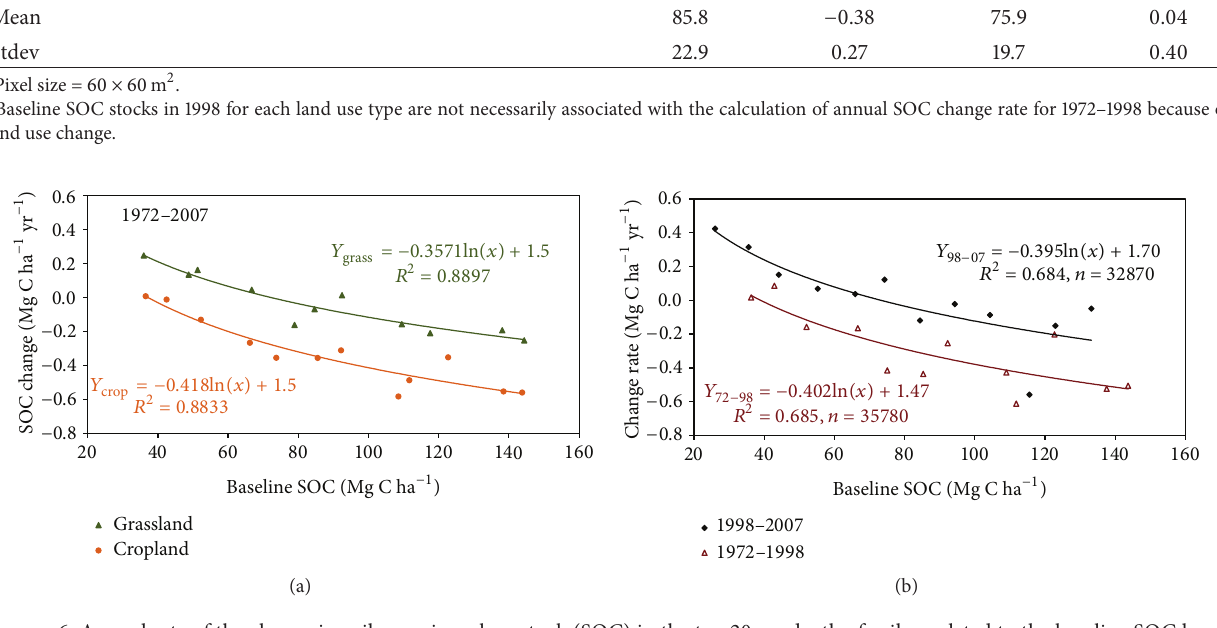
initial year of 1972 and 1998,